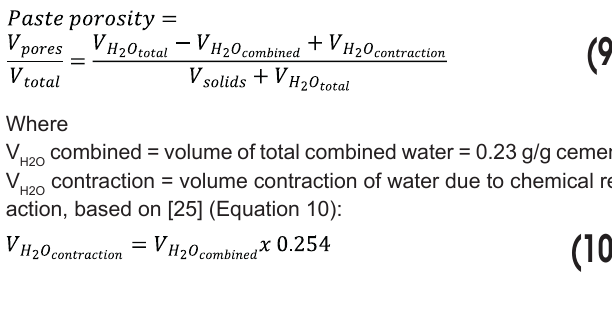
Data of material consumption, fresh state parameters, compressive strength at 7 and 28 days Design conventional parameters